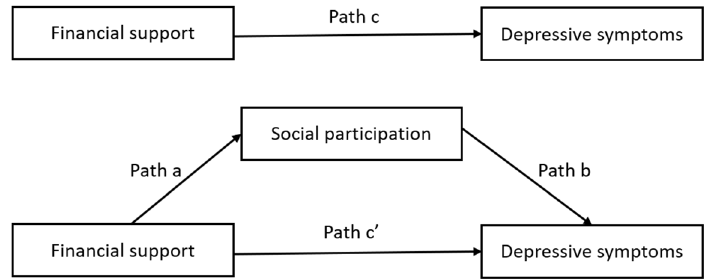
Figure 2. Conceptual framework of the present study.